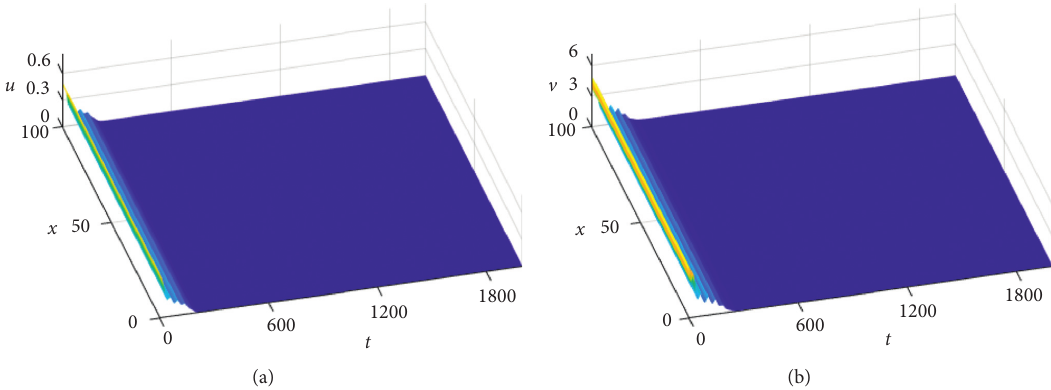
� 0 . 01, and μ � 20. 1 2